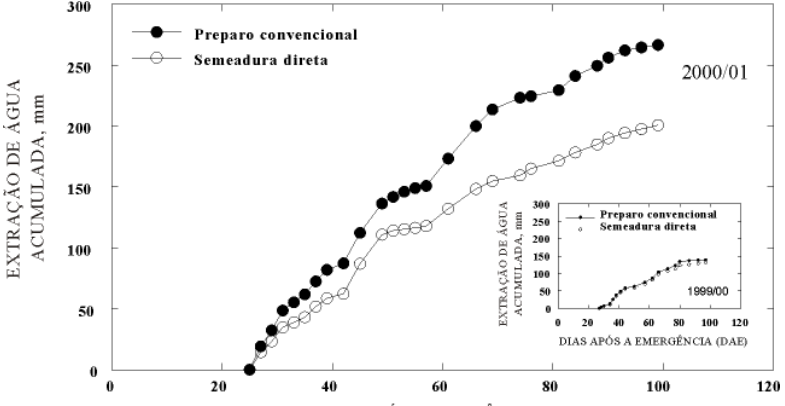
Figura 3. Extração acumulada de água por plantas de milho submetidas a déficit hídrico terminal e cultivadas em sistemas de cultivo plantio direto e convencional, em dois anos de cultivo. A figura menor, inserida no gráfico principal, corresponde ao ano agrícola 1999/00. Santa Maria, RS,